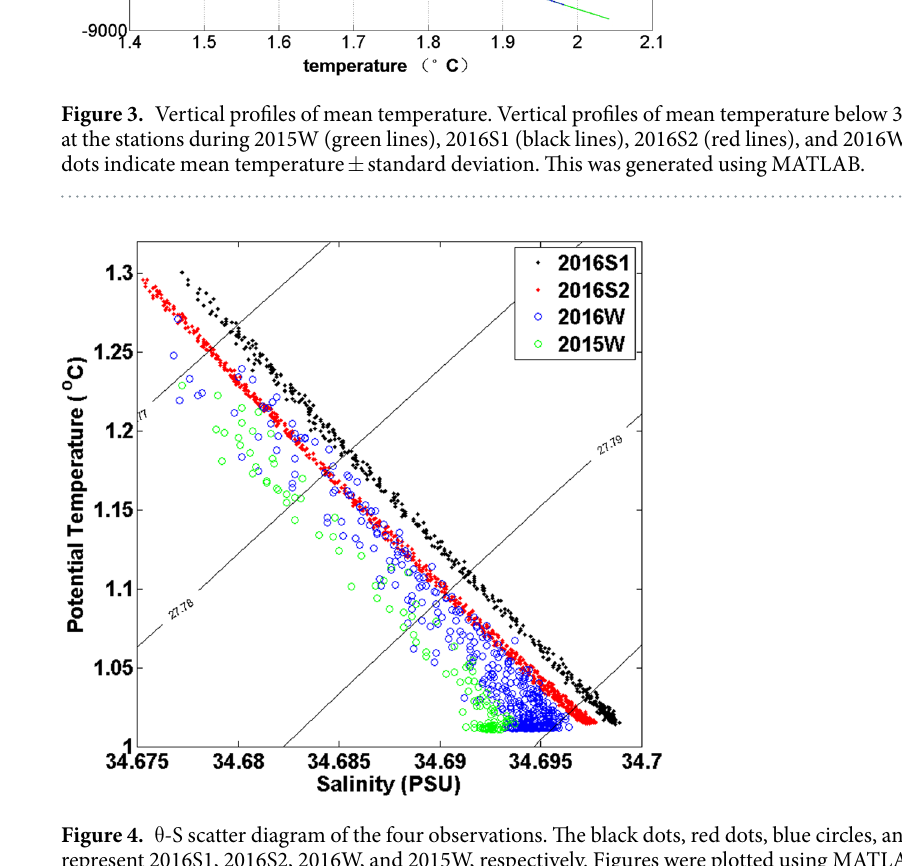
Between the depths of 4000 and 4800 m, there is an apparent minimum temperature (Fig. 3). The tempera- ture minimum values are almost the same between the four cruises, and is about 1.446–1.488 °C. Temperature increases to 2.042 °C at 8727.3 m in 2015W and 1.981 °C at 8389.9 m in 2016W due to adiabatic pressure 3 . The depth of the temperature minimum layer in the summer (2016S1 and 2016S2) is approximately 4700 m (4800 dbar), and 4250.5–4598.9 m in the winter (2015W and 2016W). The depth of the temperature minimum layer is shallower in the winter than that in the summer. The temperature minimum values of three stations in the winter of 1992 were 1.455–1.470 °C 3 , which is consistent with that measured during the four cruises. The minimum tem- perature appeared at approximately 4700 dbar in the winter of 1992, which is also shallower than that measured in the summer of 2016. In conclusion, the temperature minimum measured during the four cruises are almost same, but its depth is shallower in winter than that in summer. A θ -S diagram of the four observations is presented in Fig. 4. At the same potential temperature below 1.3 °C, the salinity measured during 2016S1 is highest, followed by 2016S2, 2016W, and 2015W. The salinity measured during 2016S1 is 0.004 PSU higher than that measured during 2015W at the same potential temperature. 2016S1 and 2016S2 were conducted during the summer of 2016. The CTD casts of 2015W and 2016W were conducted during the winters of 2015 and 2016, respectively. Therefore, deep water is more saline in the summer than that in winter at the same potential temperature. The contours of the potential temperature and potential density in the meridional transect of 2016S1 along 142°E (Fig. 5) are depressed over the trench. During 2016S2, the contours of potential temperature and potential density along 141.5°E are also depressed, and the depression is closer to the northern flank than that in 2016S1. In the Izu-Ogasawara Trench, the transects of potential temperatures at 34°N and 30°N are very similar 7 . However, in the Mariana Trench, although the two transects are only 54.48 km apart, the depressions of the potential tem- perature and potential density contours are closer to the northern flank during 2016S2 than those in 2016S1. This